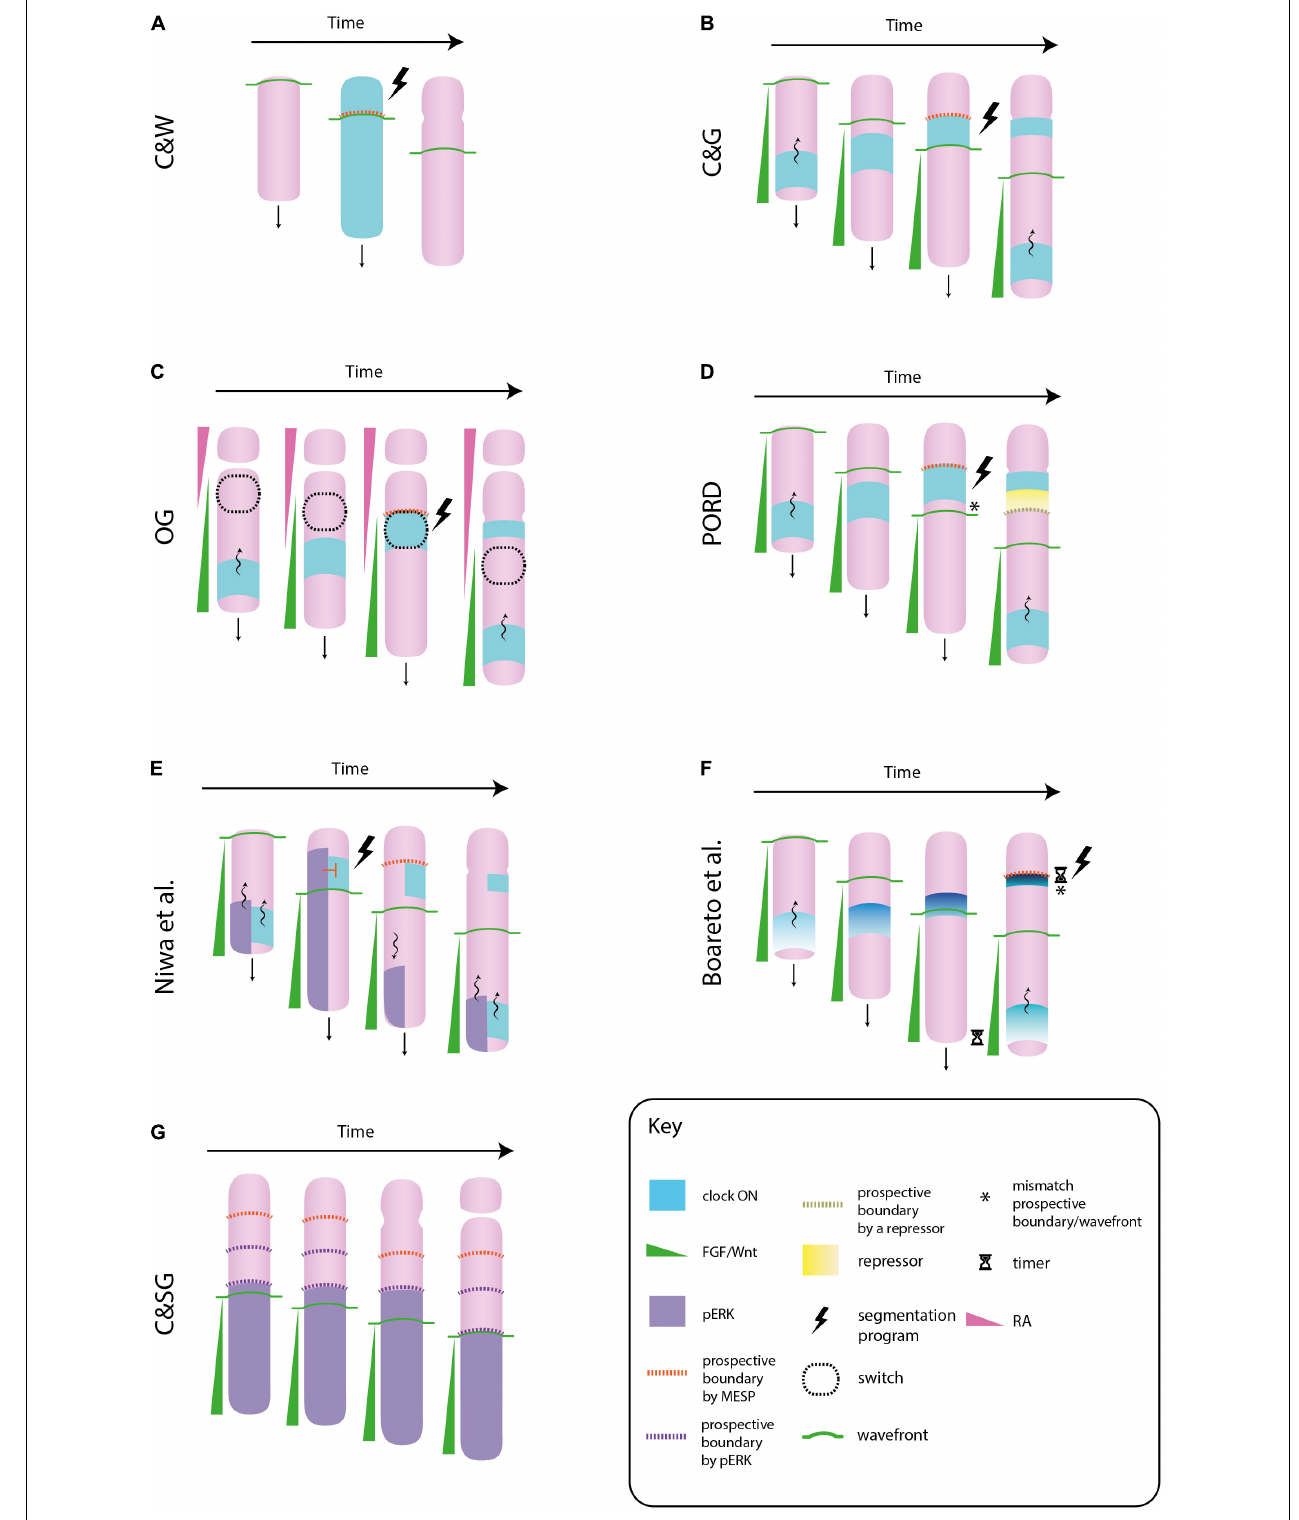
FIGURE 1 | Different molecular models of somitogenesis. In the original clock and wavefront model (C&W), cells oscillate in phase, i.e., the whole paraxial mesoderm would switch “on” or “off” the clock gene at once. The interaction between the clock and the wavefront transforms a whole block of mesenchymal cells into a somite (an epithelial sphere) (A) . In the clock and gradient model (C&G), the wavefront is formed by a FGF gradient that progressively regresses toward the tail. Cells